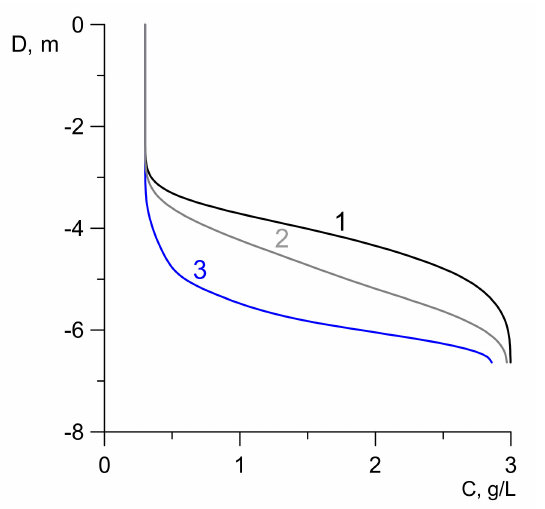
Figure 10. Change in mineralization near the BKPRU-4 water intake at a distance of 100 m from the